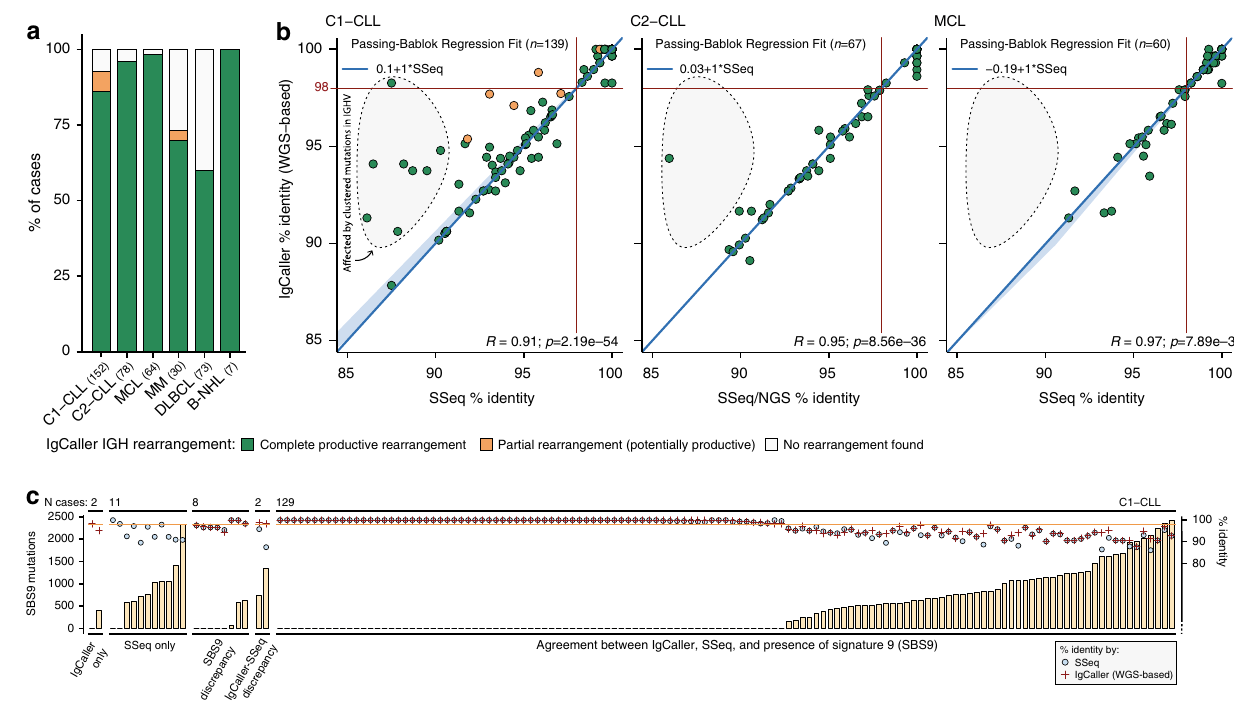
Fig. 2 Benchmarking of IgCaller: characterization of the IGH locus. a Bar plot showing the percentage of cases with productive IGH rearrangements by IgCaller in each cohort. b Dot plots of the percentage of identity of the rearranged IGHV sequence to the germ line by IgCaller ( y axis) and SSeq/NGS ( x axis). The 95% con fi dence interval is depicted by the light blue area. The gray area highlights cases in which the presence of a high density of clustered mutations impairs an accurate identi fi cation of the percentage of identity. P values are from t -test. c Comparison of the number of mutations associated with signature 9 (SBS9, left y axis) and the identity of the rearranged sequence both by SSeq and IgCaller (right y axis) in the C1-CLL cohort. Source data are provided as a Source data fi